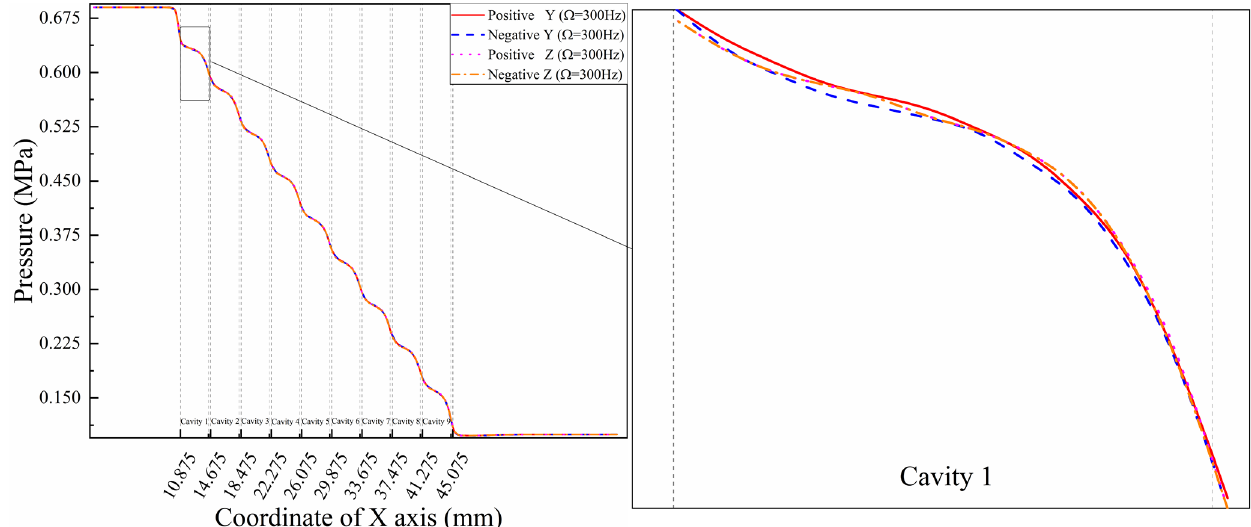
Ω Ω = 300 Hz). = 300 Hz). Figure 9. Pressure comparison of different circumferential directions ( Ω = 300